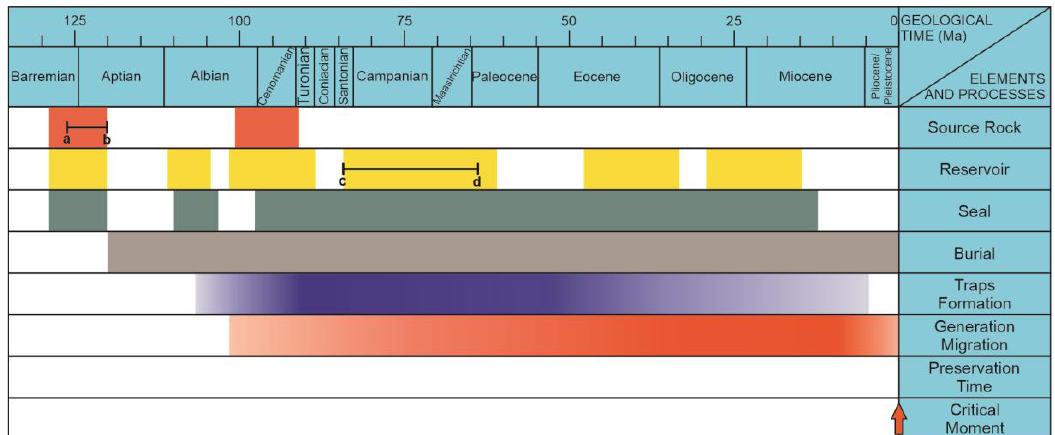
Figure 3. Petroleum systems event chart of the Campos Basin, adapted from Alves [8]. Inside a–b line marks the period of generation (from Barremian to Aptian) and the c–d line indicates the period of the principle reservoirs (from Santonian to Maastrichtian) of the Lagoa Feia-Carapebus petroleum system.